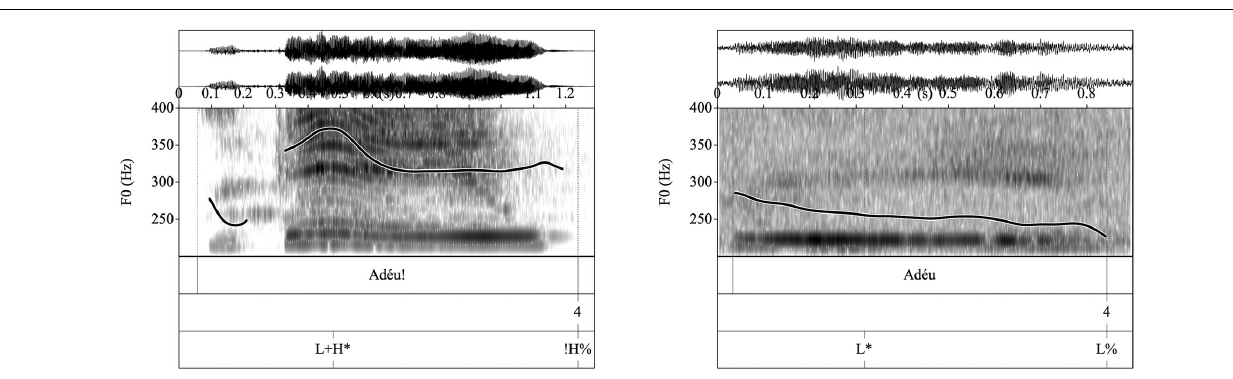
FIGURE 2 | (Left) Waveform, spectrogram and F0 trace for the prosodically appropriate expressive farewell “Adéu!” “Bye!” scored 2 for prosody and produced with a L + H* nuclear configuration and followed by a !H% boundary tone. (Right) Waveform, spectrogram and F0 trace for the same utterance with inappropriately unexpressive prosody in the form of a L* nuclear accent and followed by a L% boundary tone. This utterance would receive a score for prosodic appropriateness of